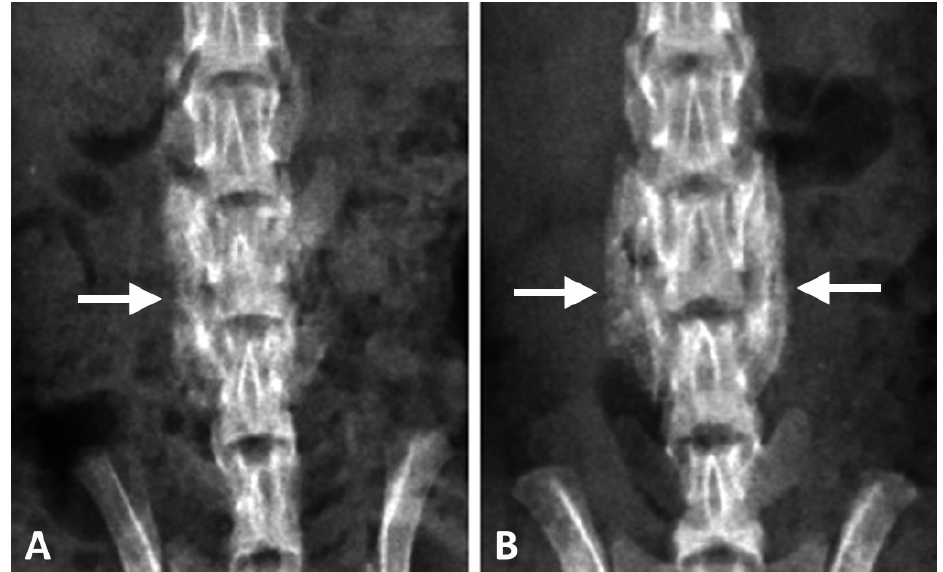
Figure 4. Posteroanterior radiographs after post-operative four weeks of the spines that underwent posterolateral lumbar fusion with ( A ) DCP-rich CPC or ( B ) DCP-rich CPC + 0.4 mL collagen. The arrows indicate fusion mass.